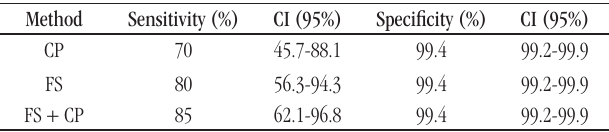
taBLE 1 − Epidemiological index values comparing CP, FS and both methods combined in breast sentinel lymph node